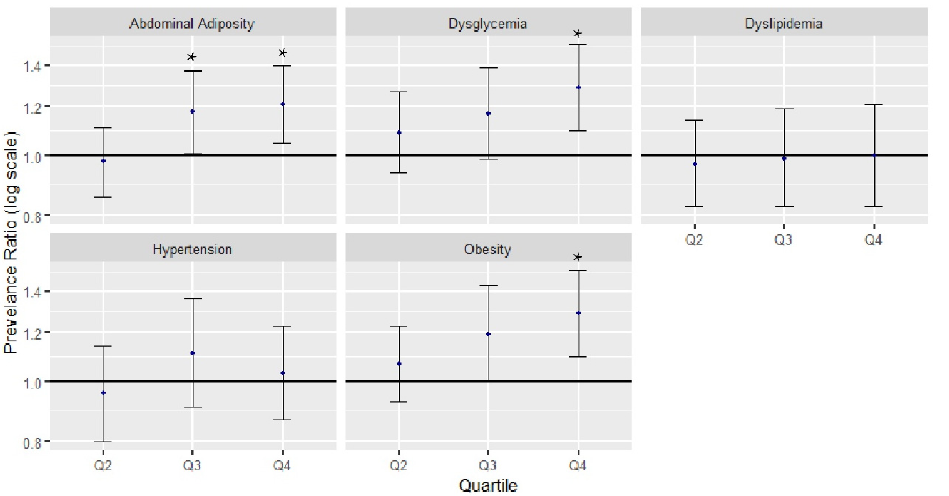
Figure 1. Adjusted prevalence ratio of cardiometabolic risk factors by subsidy score quartile in the